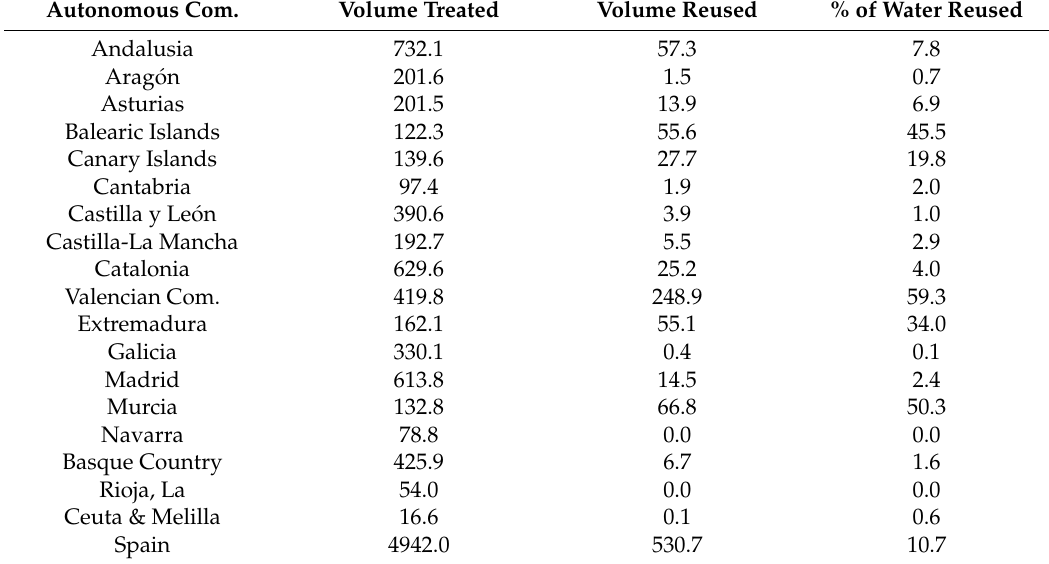
Table 3. Volume treated and reused in Spain per Autonomous Community (2014) (hm 3 ). Autonomous Com. Volume Treated Volume Reused % of Water Reused Andalusia